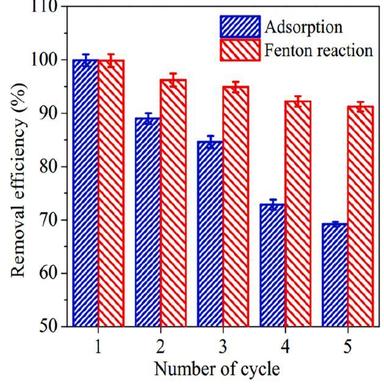
Adsorption capacity and Fenton catalytic efficiency of FG2I according to number of cycles (Adsorption: 0.02 g material, 20 mL of 200 mg/L MB, 180 min, pH 8.5; Fenton catalytic: (20 mL of 200 mg/L MB, 1 mL H2O2 30%, 180 min, 50 ◦C, and 0.01 g FG2I).